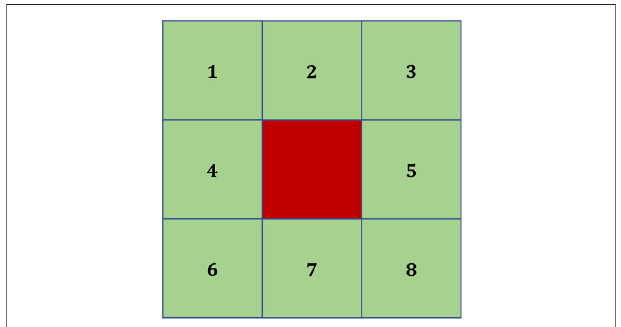
FIGURE 9 | A unit cell for the calculation of mixing index. The center grid is colored in red and the periphery grids are colored in green. For the evacuation area con fi gured in Section 2.1 , there are 1,600 such unit cells in